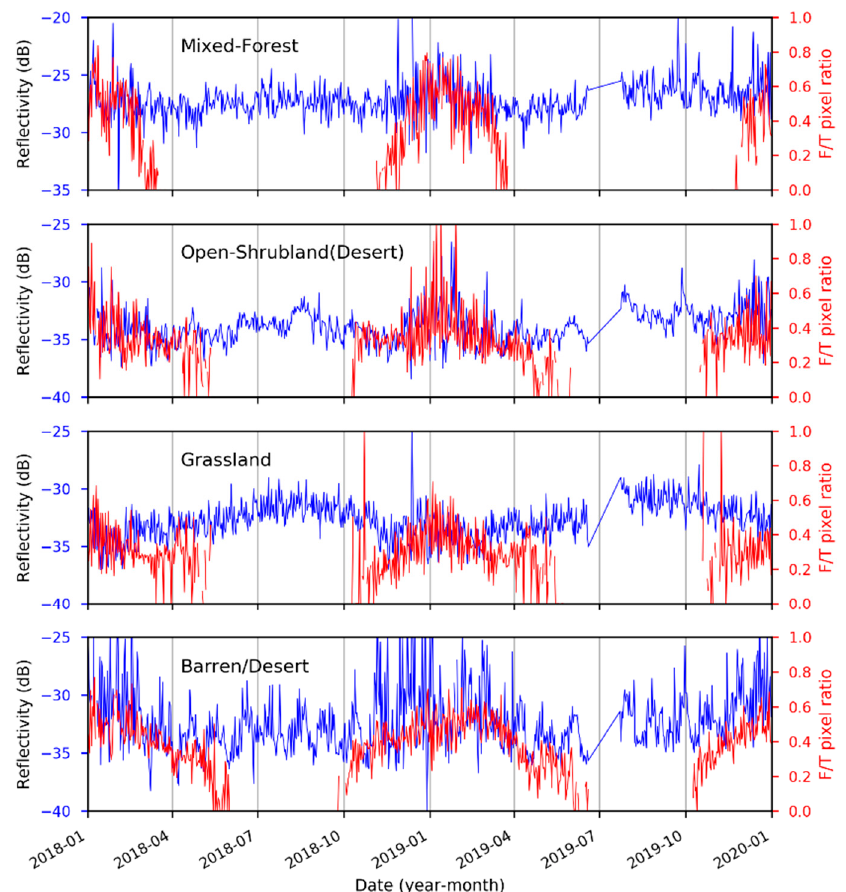
Figure 5. The time series of surface reflectivity versus Soil Moisture Active Passive (SMAP) provided freeze ratio area under different land cover types on Tibetan Plateau.